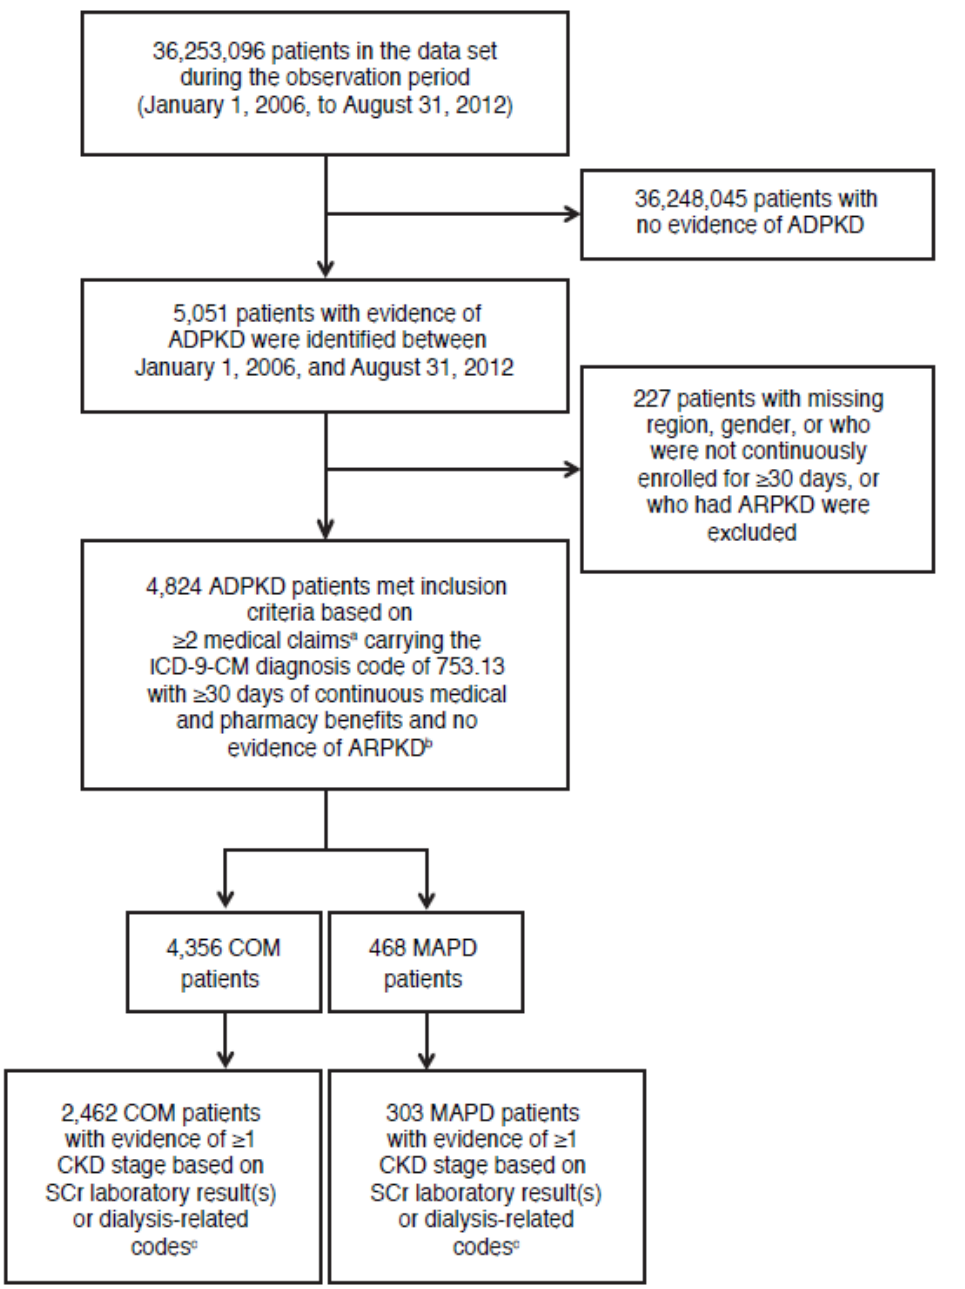
Figure 1. Summary of Patient